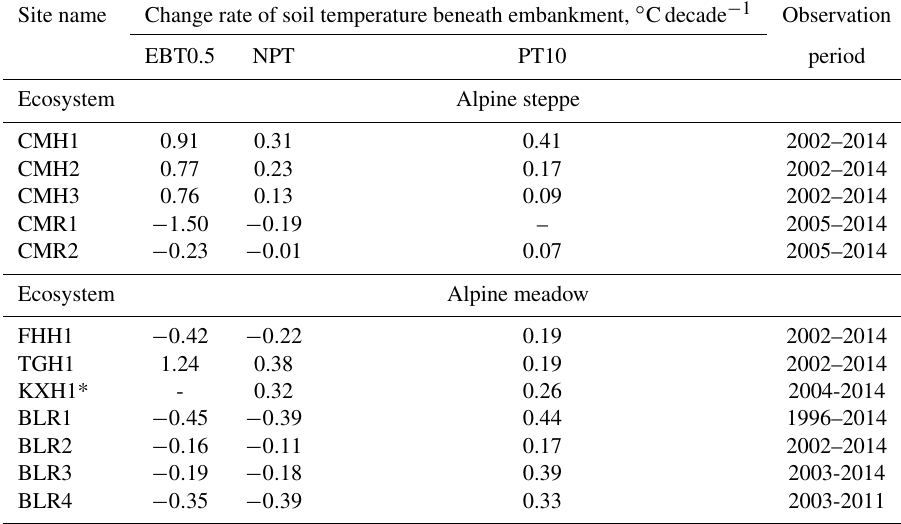
Table 4. Variation rate of mean annual soil temperature at 0.5m depth beneath embankment base (EBT0.5), near-permafrost table temperature (NPT), and permafrost temperature at depth 10m (PT10) beneath embankment.